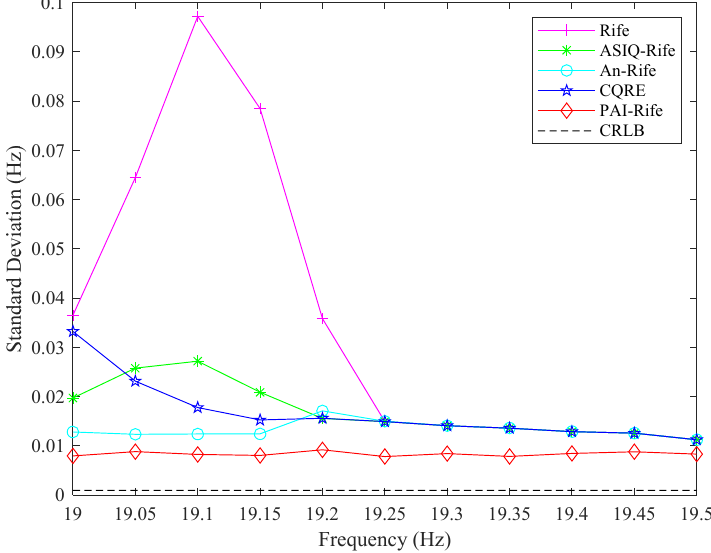
Figure 3. Standard deviation of PAI − Rife and other Rife algorithms at different frequencies.